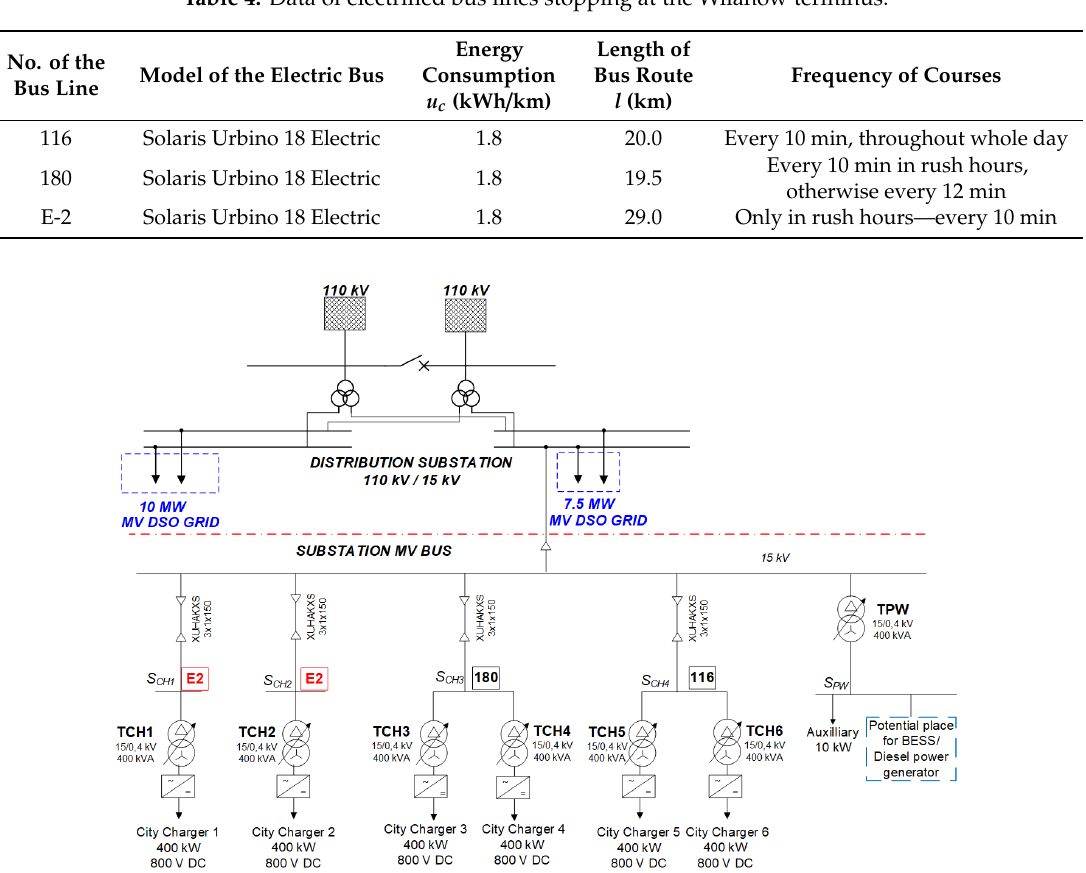
Figure 2. Electric scheme of the Wilanów terminus model for further analysis.